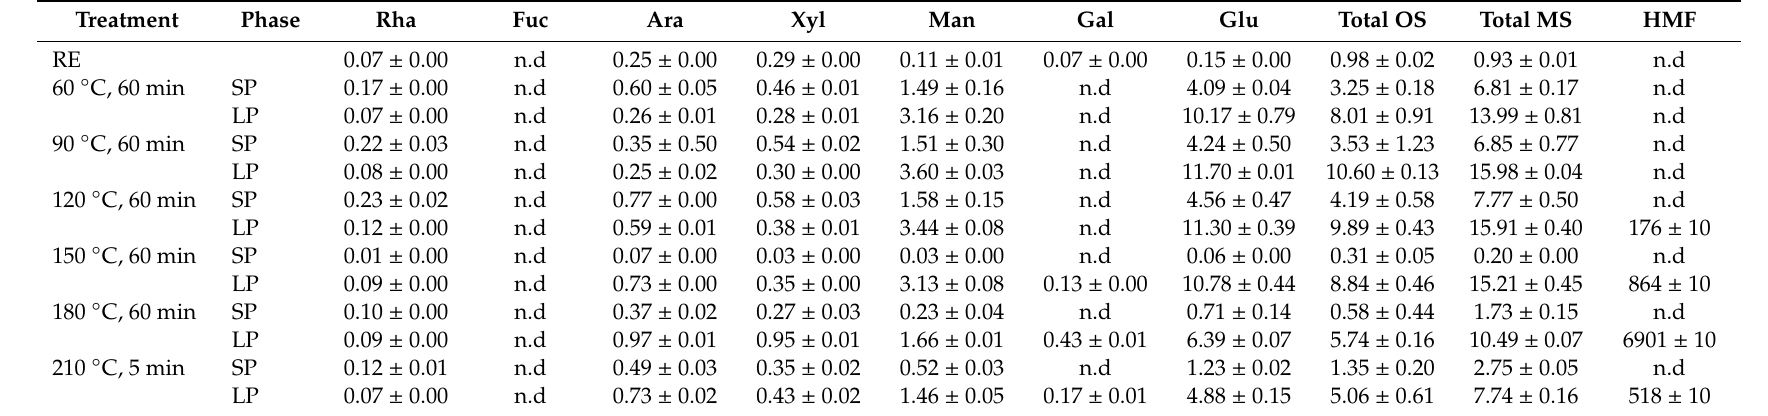
Table 3. Glycoside composition (g sugar / kg of raspberry extrudate), total monosaccharides (Total MS) and total oligosaccharides (Total OS) and hydroxymethylfurfural (HMF, mg / kg of raspberry extrudate) of untreated raspberry extrudate (RE), solid phase (SP), liquid phase (LP) and de-phenolized liquid phase (DLP). The